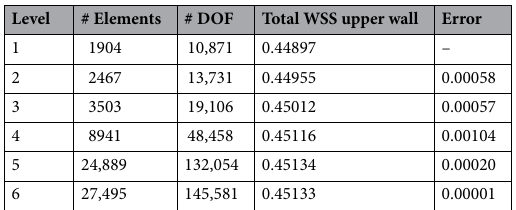
Table 1. Mesh statistics for various refinement levels.